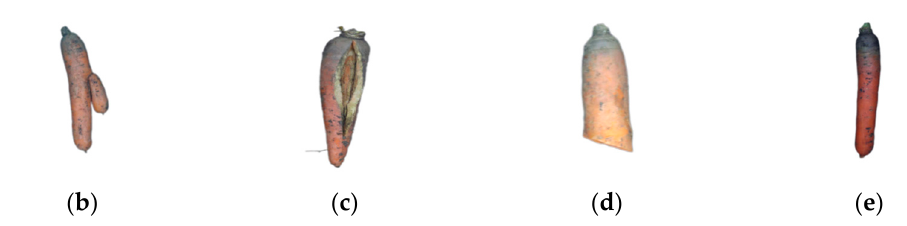
Figure 2. Part of experimental materials, ( a ) Normal; ( b ) Bifurcate; ( c ) Cracking; ( d ) Breakage; ( e ) Greenroot.